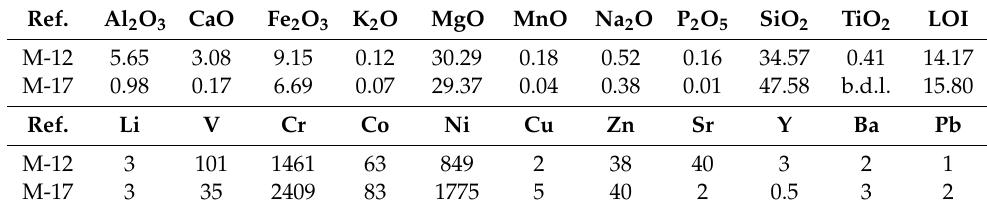
Figure 6. Sample M-12, produced from serpentine (both grey and blue-orange fibres) and carbonate (pinkish material covering the interstices of serpentine minerals). A Leica DM2500P microscope under transmitted light was used for this purpose at the University of Salamanca. Table 1. Chemical analysis of samples M-12 and M-17. Major elements in %; trace elements in ppm.